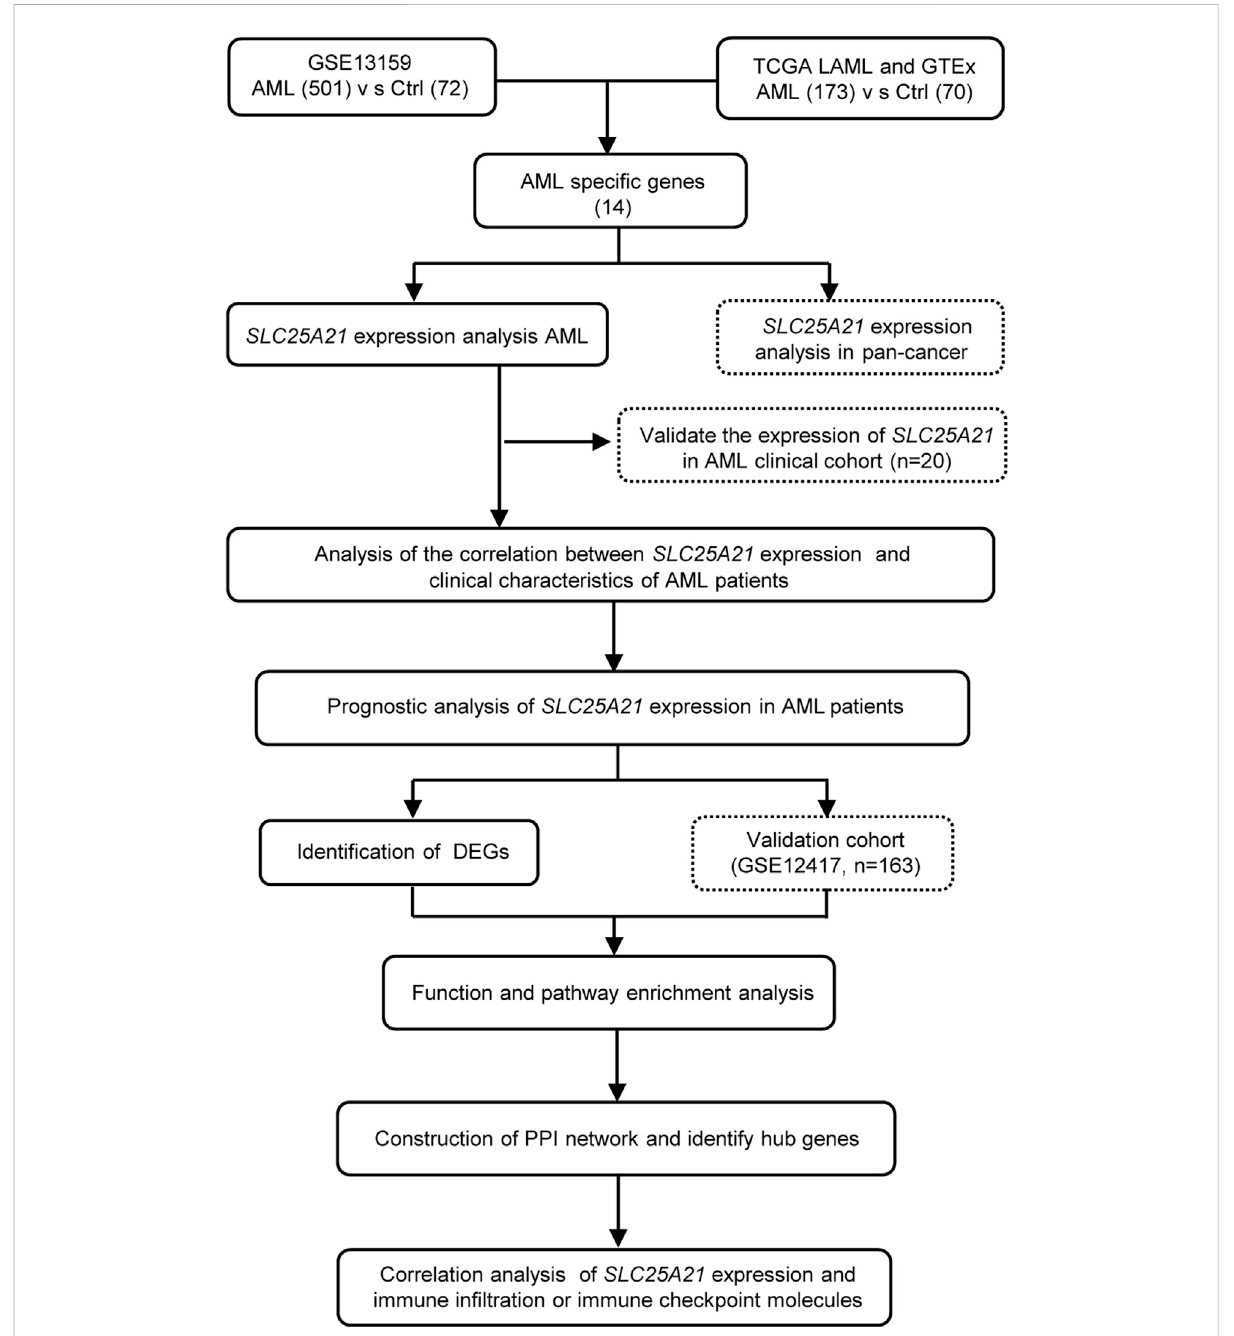
FIGURE 1 Flow chart of the